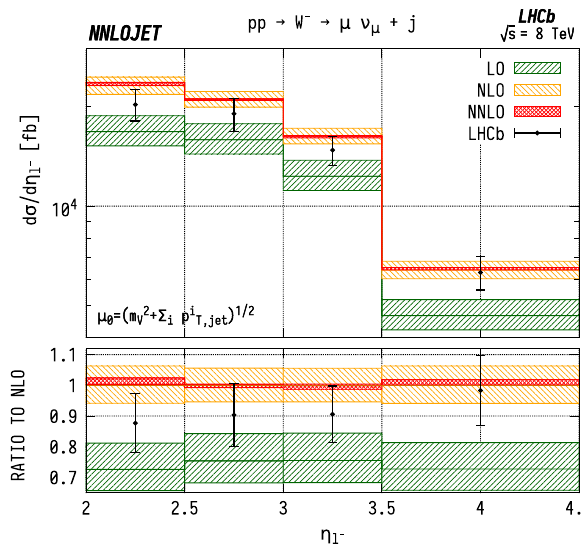
Fig. 7 Cross section differential in the pseudorapidity η of the leading jet for W + production. See Fig. 3 for details